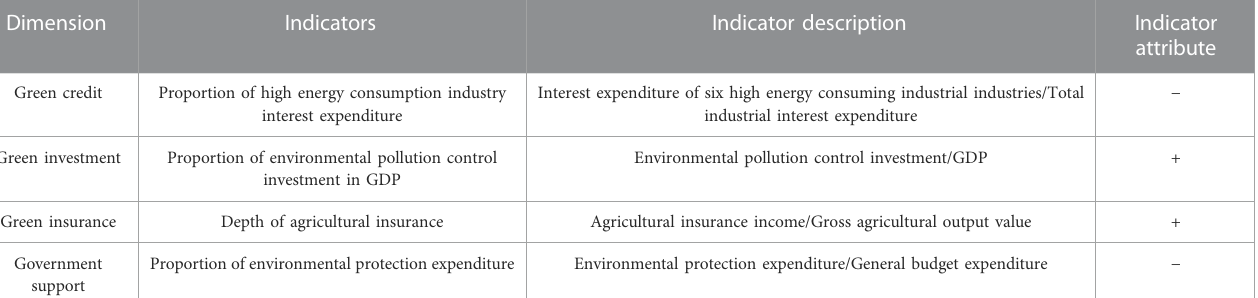
TABLE 2 Green fi nance index system.